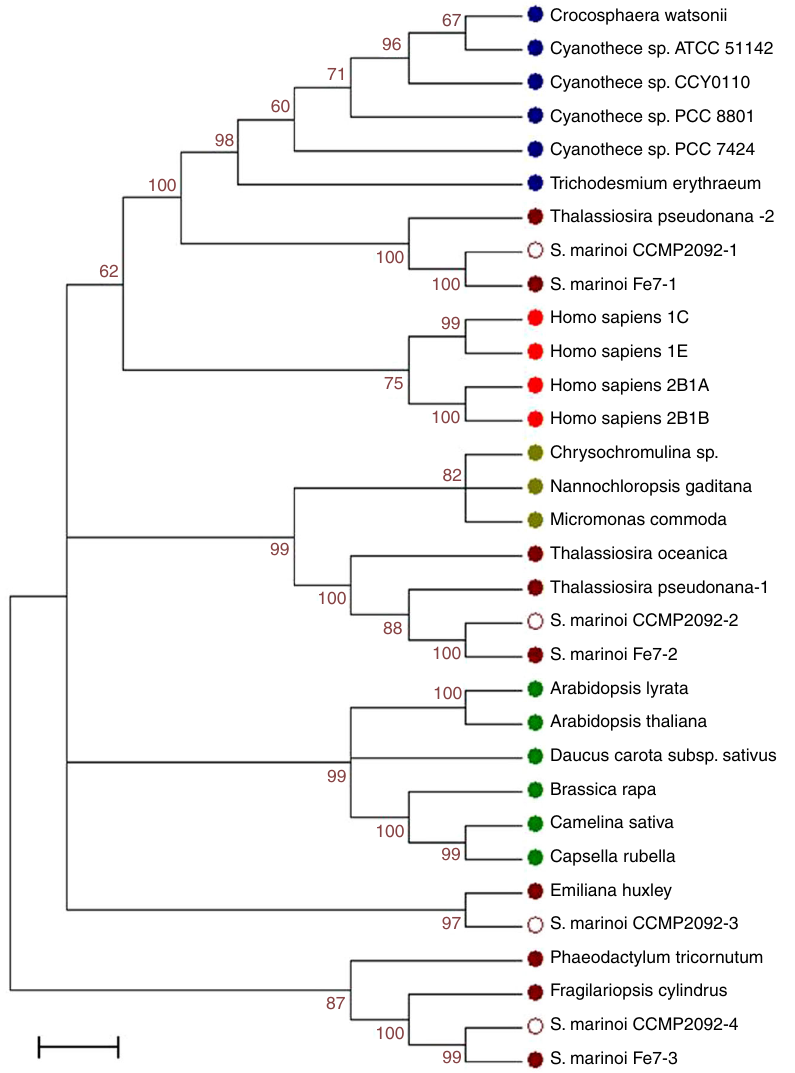
Fig. 3 Phylogenetic relationship of SULT proteins of diatoms. Phylogenetic analysis of SULTs alignment was inferred by using the Maximum Likelihood method based on the Poisson correction model. The tree with the highest log likelihood ( − 8017.2374) is shown. The bootstrap consensus tree inferred from 1000 replicates is taken to represent the evolutionary history of the taxa analyzed. Branches corresponding to partitions reproduced in < 60% bootstrap replicates are collapsed. The percentage of replicate trees in which the associated taxa clustered together in the bootstrap test is shown next to the branches. Scale bars represent 0.05 substitutions per amino acid position. The four SULT putative sequences ( S. marinoi CCMP2092-1, 2, 3, 4) were retrieved from the de novo transcriptome assembly of S. marinoi (CCMP2092) (Supplementary Table 2). Different colors represent different taxa: blue for cyanobacteria, brown for diatoms, red for human, light green for microalgae, and dark green for plants (Supplementary Table